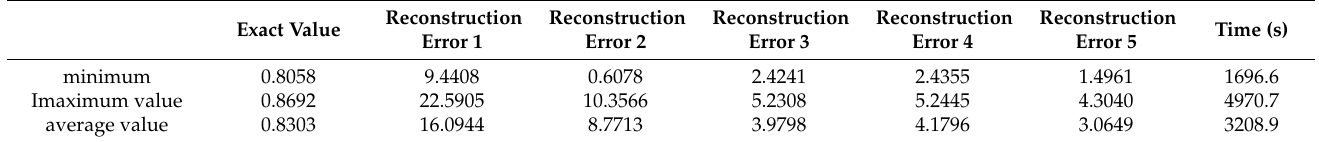
Table 3. DBN: X2000-1000-500-200-100 statistical results.